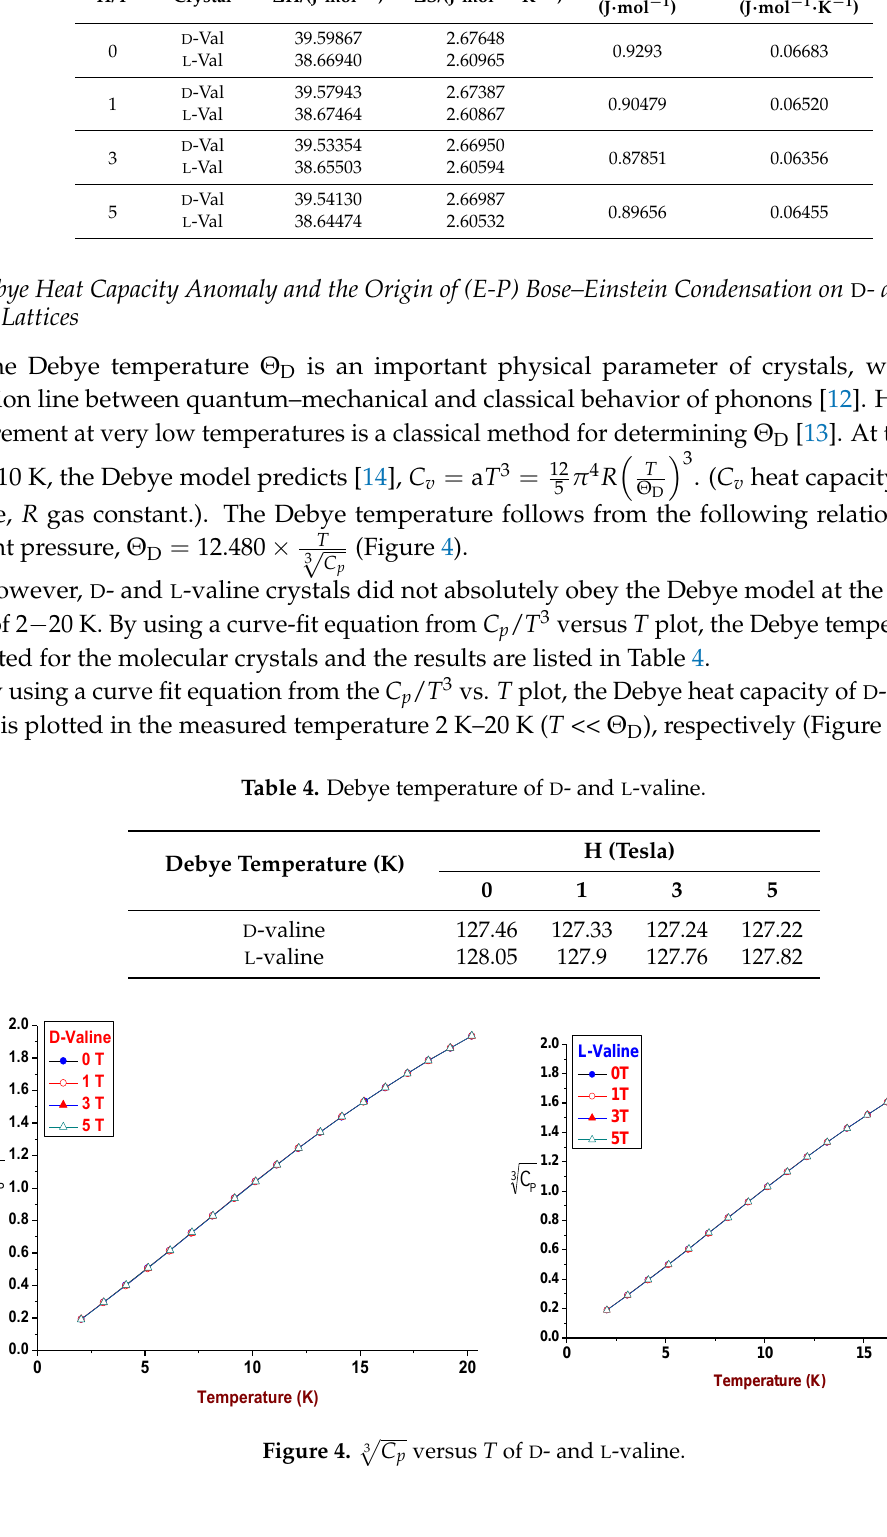
Figure 5. Temperature dependence of the heat capacities C p / T 3 of D -, L -valine. Crystals as a function of external magnetic field with H//b axis. Chrial D - and L -valine crystal lattices display optical activity related to the parity violation energy difference (PVED) show a dramatic change of the heat capacity with the Debye temperature leading to the appearance of a secondary maximum (developing a shoulder-type [7] structure) associated with the Schottky anomaly through the Bose – Einstein condensation temperature. Petro Barguno [15] proposed “ through Bose condensation to detect PVED of chiral molecules is alternative route ” . From 2 K to 20 K, most of the intramolecular motions are frozen out and the residual dynamics should be related mainly to intermolecular motions in D - and L -valine. Salam conjectured BCS superconductivity was held for the case of amino acid chains. The Cooper pairs are rather large objects (10 − 4 cm) in superconductivity transition which might occur by the hydrogen of peptide bond in helix onto the crystal lattice [11]. According to the Heisenberg Uncertainty Principle [16], 2 K is selected as the temperature of zero-point energy [17]. The necessary condition for electron – proton ( e-p ) condensation is produced by Bosonic condensates like those for Cooper pairs. The hydrogen of the peptide bond was ( e-p ) Bose – Einstein condensation at momentum space as zero momentum state from 2 K to 12 K onto D -, L -valine crystal optical lattices. The temperature of Bose – Einstein peak is 11.20, 11.32, 11.44, 11.46 K for D -valine and 11.49, 11.59, 11.73, 11.70 K for L -valine at magnetic field 0, 1, 3, 5 T, respectively (Table 5). The overwhelmingly homochiral nature of life has left a puzzle as to whether mirror-image biological systems (Figure 6) are based on a chirally inverted version. Mirror image twins of one another have led to an intriguing question as to whether a parallel mirror image world of biology running on a chirally inverted version of molecular machinery could be found in the universe and observed in the laboratory [16].